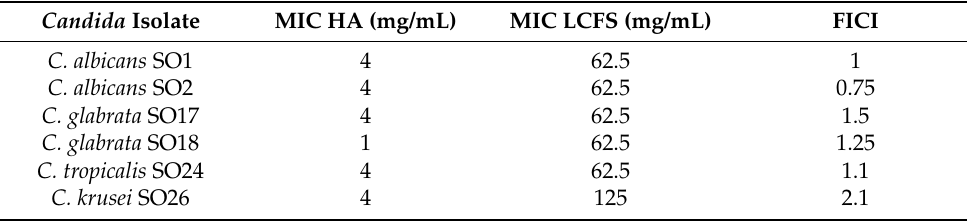
Figure 1. Growth curves of ( a ) C. albicans SO1, ( b ) C. albicans SO2, ( c ) C. glabrata SO17, ( d ) C. glabrata SO18, ( e ) C. tropicalis SO24, and ( f ) C. krusei SO26 in the presence of different concentrations of HA (0.25–4 mg/mL). Table 1. MIC (mg/mL) of HA and LCFS alone, and FICI values calculated on Candida growth inhibition data obtained by HA and LCFS combined treatment at 24